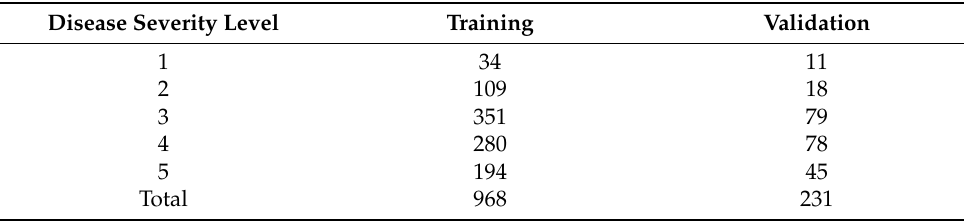
Table 1. Disease severity data